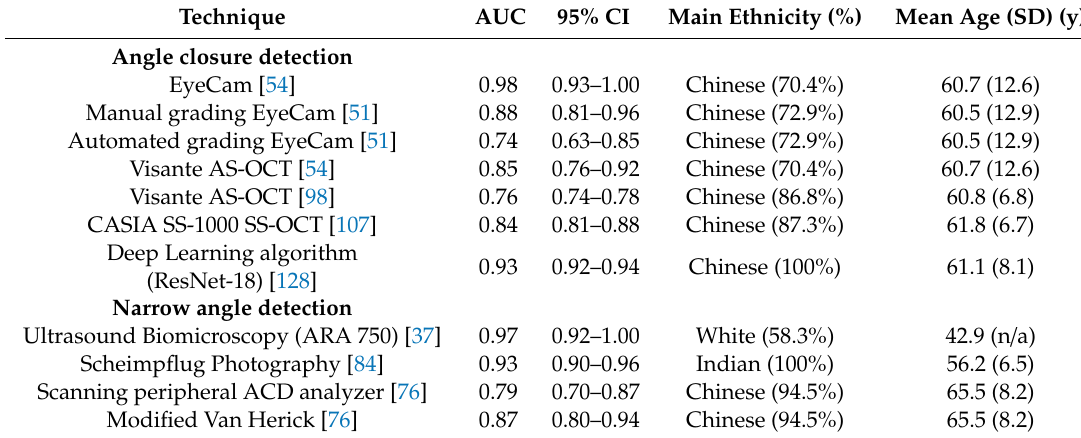
Table 2. Area under the curve (AUC) with 95% Confidence Interval (CI) for the detection of angle closure and narrow angle. Data reported by techniques and